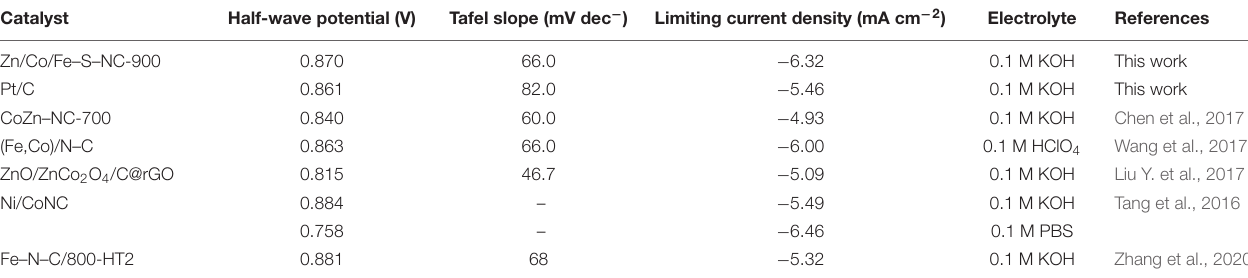
TABLE 1 | Comparison of ORR performances of catalysts in this paper with those from literature. Catalyst Half-wave potential (V) Tafel slope (mV dec − ) Limiting current density (mA cm − 2 )